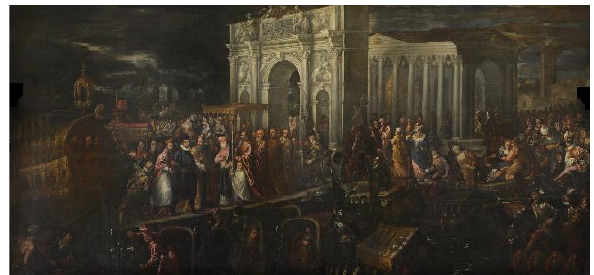
Figure 6. Orthophoto of Vicentino’s painting.